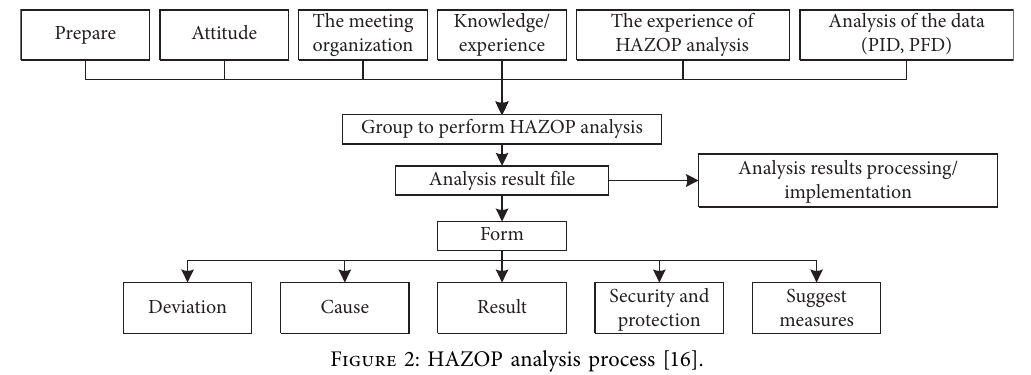
Figure 2: HAZOP analysis process [16].